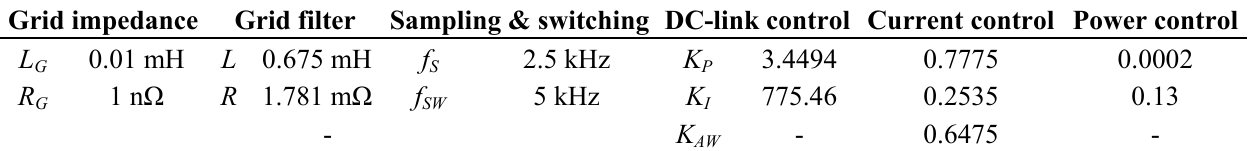
Table 2. Simulation parameters of the VSC-based systems.